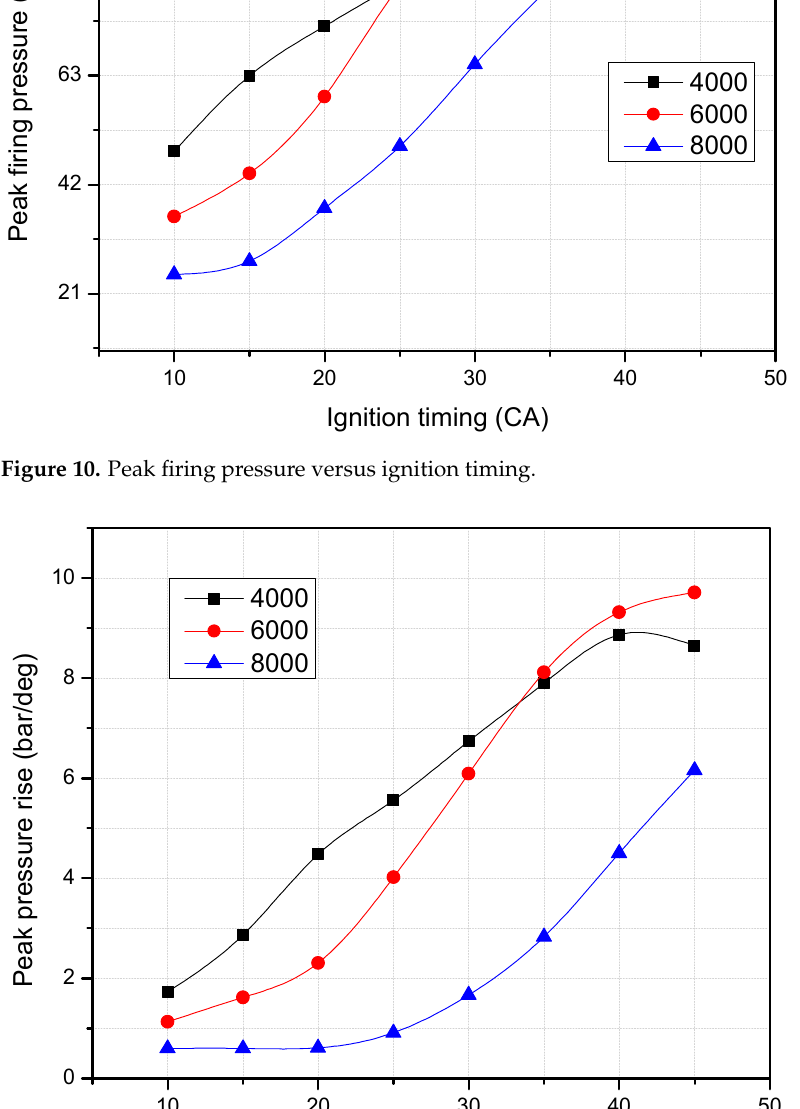
Figure 11. Peak pressure rise versus ignition timing.